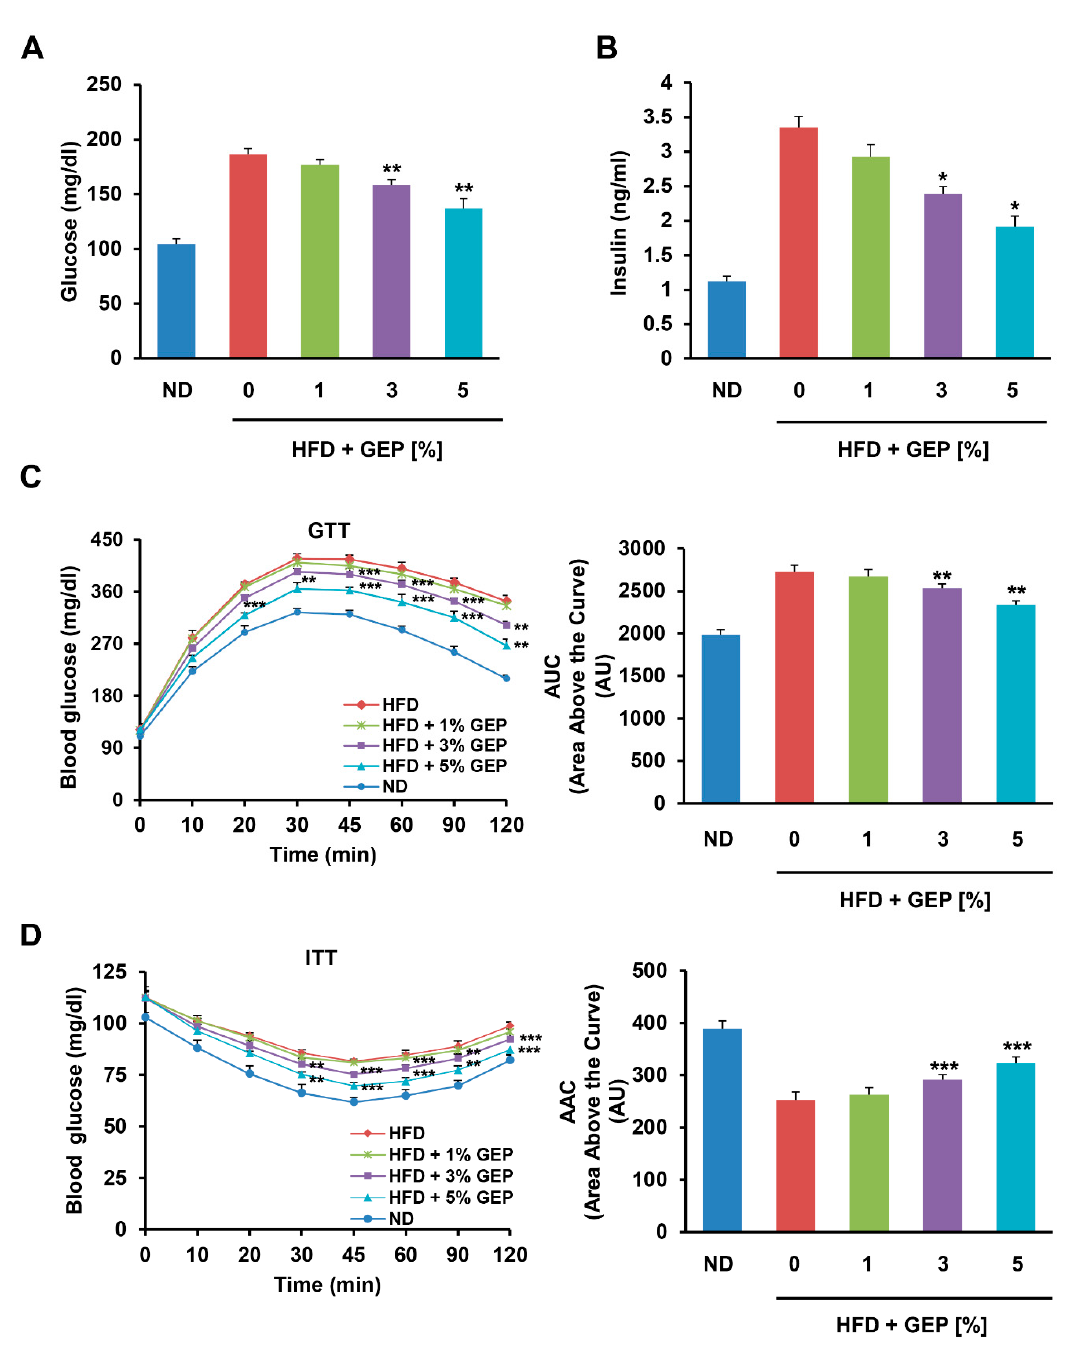
Figure 4. GEP improved glucose metabolism. Serum ( A ) glucose and ( B ) insulin levels after 12 weeks of GEP treatment. ( C ) Glucose tolerance test (GTT) and the area above the curve (AAC). ( D ) Insulin tolerance test (ITT) and the AUC. Data represent the mean ± SD of six to seven individual mice. Significant differences compared to the HFD group (control) were determined by one-way ANOVA; * p < 0.1, ** p < 0.01, *** p < 0.001. ND: normal chow diet group; HFD: high-fat diet group; HFD + GEP: high-fat diet and Ganoderma lucidum extract powder.